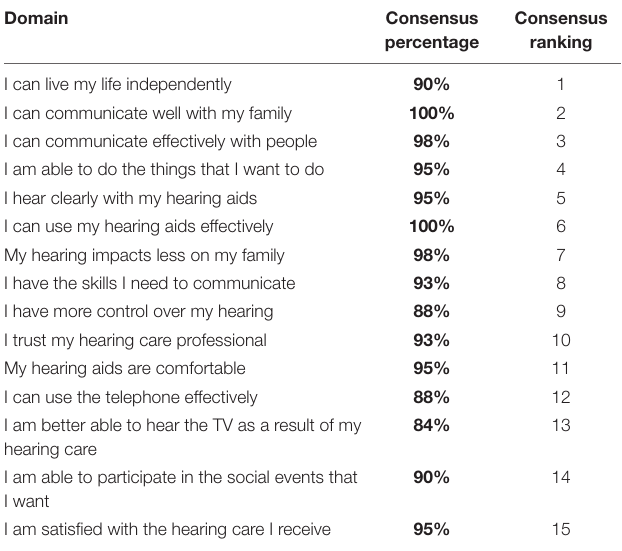
TABLE 4 | Results from the outcome domains section among the consumer